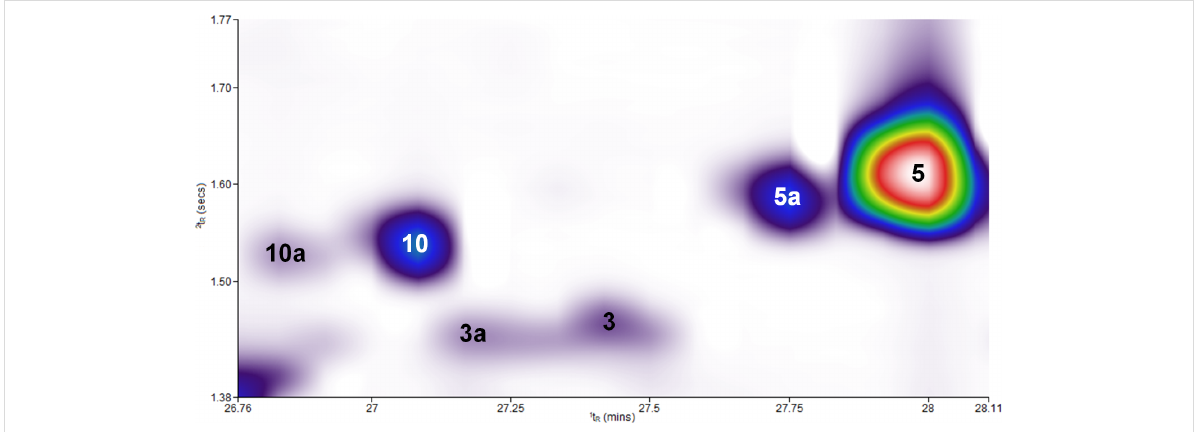
Figure 3: Detailed part of the two-dimensional contour plot (Figure 1) to demonstrate the result of a successful feeding experiment after administra- tion of the stable isotope-labeled precursor [6,6,6- 2 H 3 ]-(±)-mevalonolactone ( d 3 -MVL) to isolated exocarp of grape berries (Lemberger cultivar). The regions labeled with the numbers 10 , 3 and 5 correspond to the genuine sesquiterpene hydrocarbons as defined in Table 1. 10a ( d 8 ), 3a ( d 9 ) and 5a ( d 8 ) are the isotopologues with the highest, possible incorporation of deuterium when d 3 -MVL is used as precursor (the maximum possible number of deuterium atoms incorporated is given in brackets). The 3D view of the chromatogram section shown can be found in Supporting Information File 1.